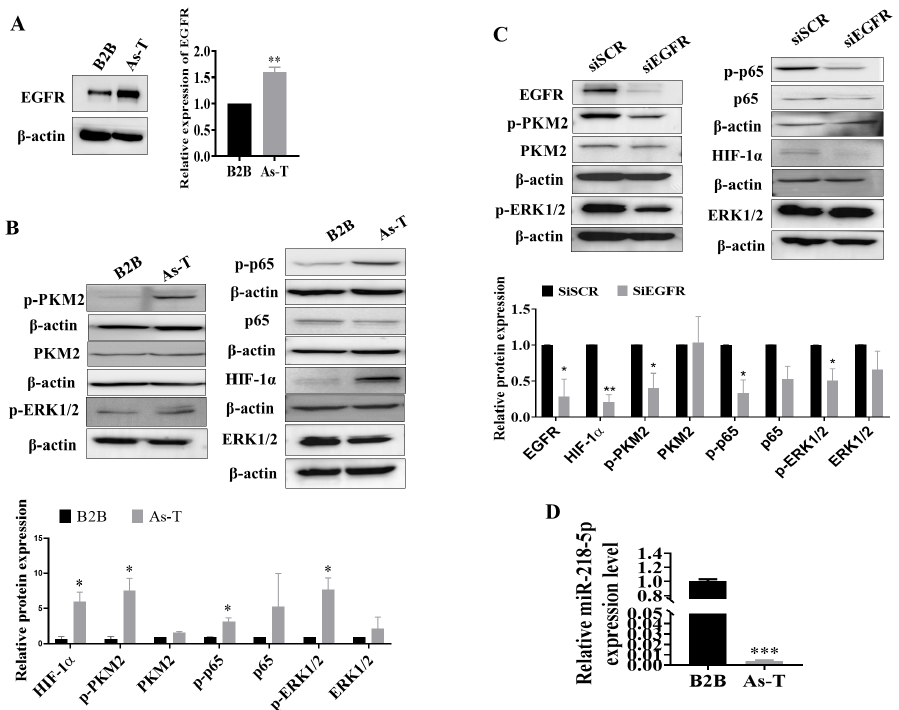
Figure 1. Upregulation of EGFR and its downstream targets PKM2, ERK1/2, NF- κ B p65, and HIF-1 α expression, and downregulation of miR-218-5p in As-T cells. ( A ) Expression of EGFR and β -actin in parental BEAS-2B (B2B) and As-T cells using an immunoblotting assay. ( B ) Expression levels of phospho-PKM2 (p-PKM2), PKM2, p-p65, p65, p-ERK1/2, ERK1/2, HIF-1 α , and β -actin in protein extracts of B2B control and As-T cells. ( C ) As-T cells transfected with siRNA against EGFR or scrambled control (siSCR) at concentration 100 nM. After 72 h, immunoblotting assay was performed. ( D ) Expression of miR-218-5p in B2B and As-T cells using TaqMan real-time RT-PCR assay. Data represent the mean ± standard error (SE) of three independent experiments. * p < 0.05, ** p < 0.01, and *** p < 0.001 compared to B2B cells. The original western blots of this figure is Figure